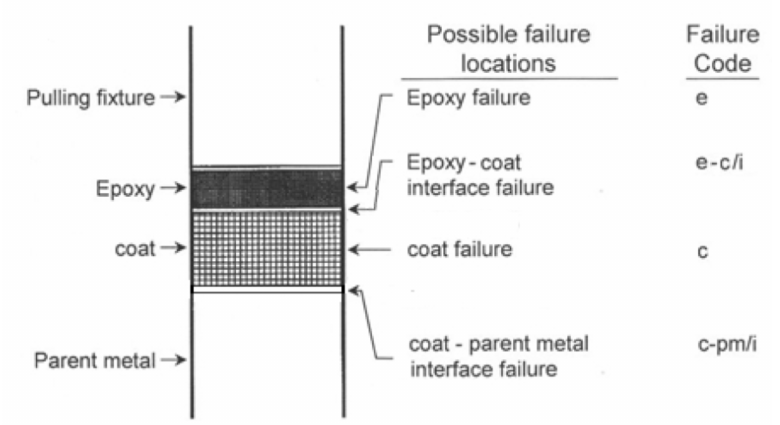
Figure 11. Schematic showing the different failure mode characterisations in the adhesive bond strength